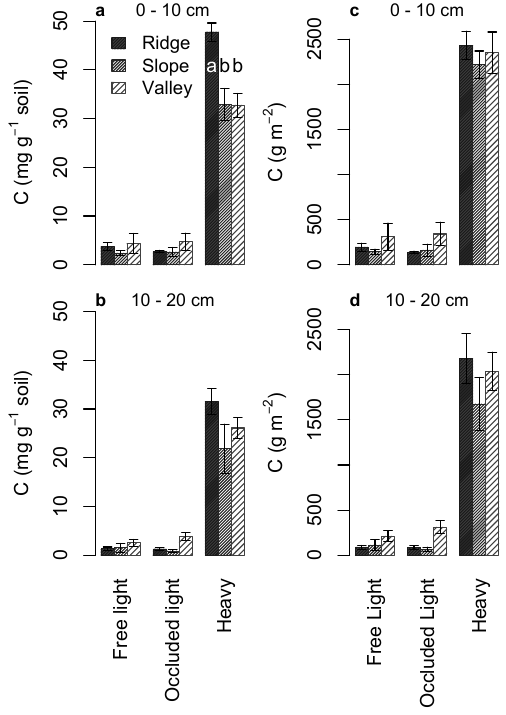
Figure 2. Carbon concentrations and stocks (mean ± SE, n = 5 for each bar) by density fraction, catena position, and depth increment. Means with different letters are significantly different. Occluded light fractions were greatest in valleys when compared across po- sitions, irrespective of